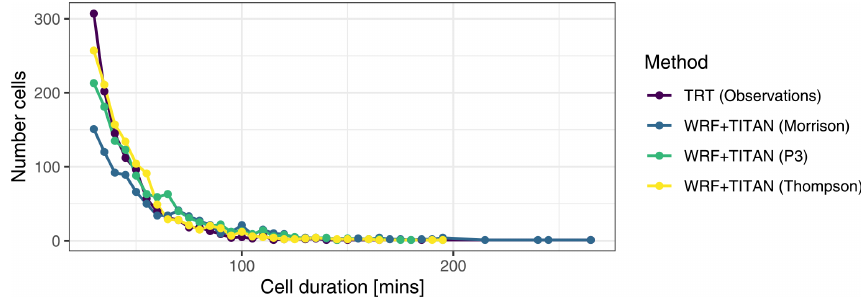
Figure 12. The number of cells detected by cell duration for observations and simulation outputs.